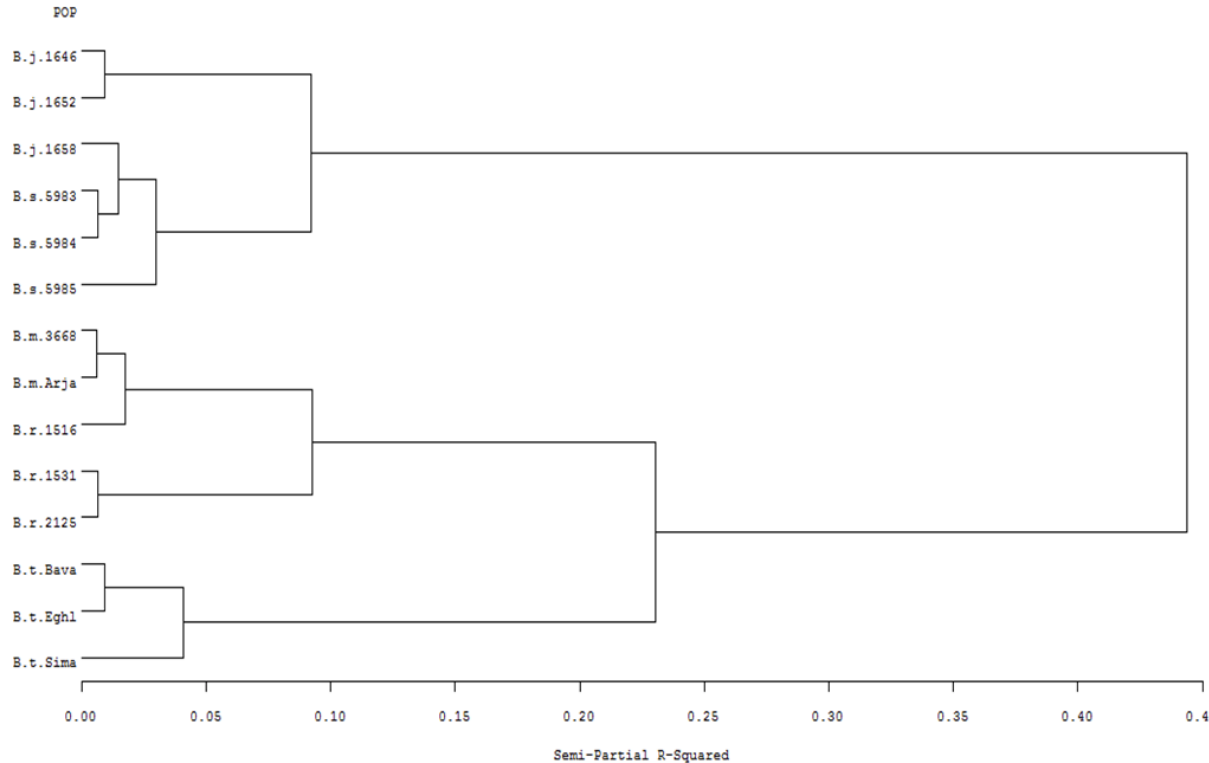
Figure 3. Dendogram of 14 populations of Bromus by analyzing nine karyotipic parameters using Ward ‘s cluster analysis